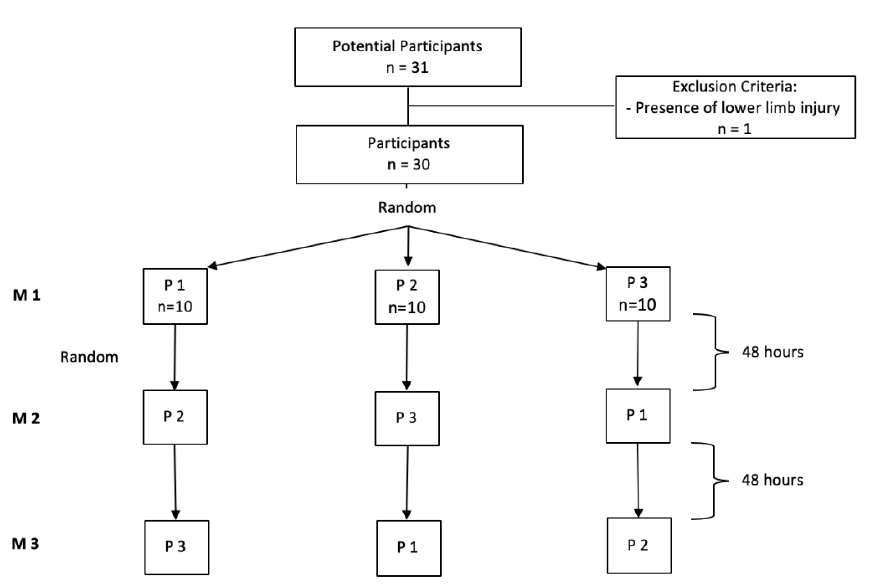
Figure 2. The randomly determined order of the pressure (P) applied in each session/moment